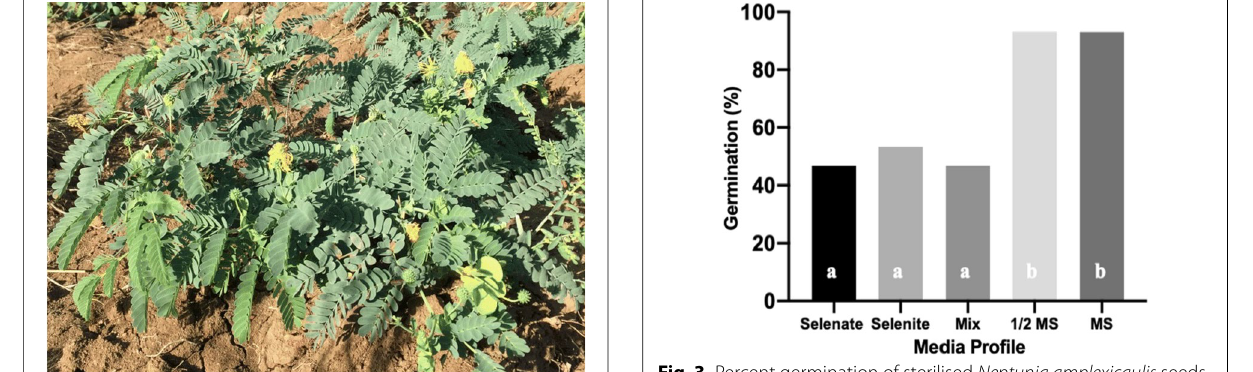
Fig. 3 Percent germination of sterilised Neptunia amplexicaulis seeds cultured on various media profiles; Full strength MS with addition of 40 ppm Se in the form of selenate, selenite, or a mix of both at a ratio of 20:20, half strength MS and plain full strength MS. Columns with same letter indicate no significant difference at P < 0.05. (n